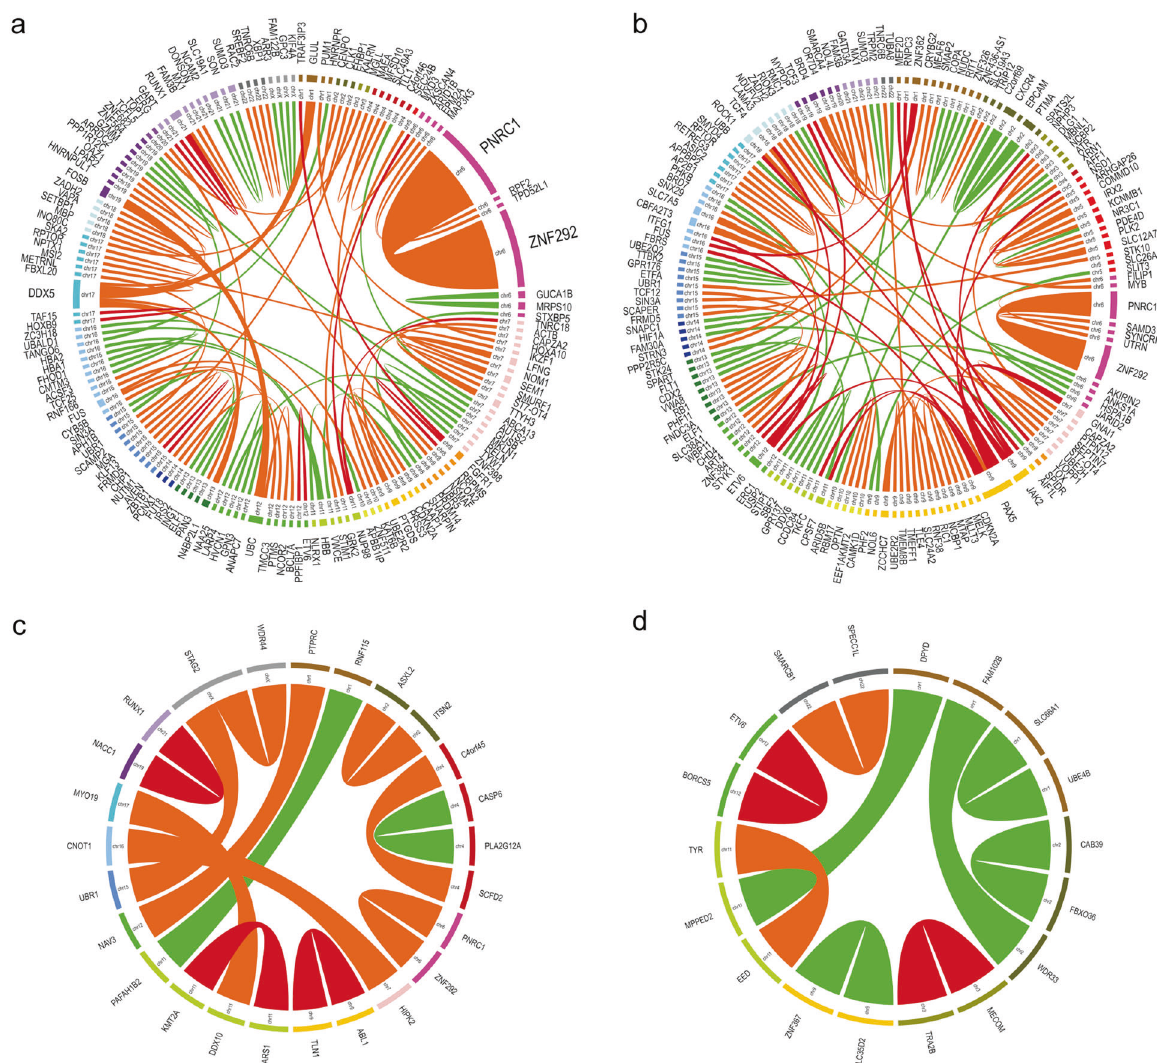
Fig. 6 Novel fusion genes detected in AML, B-ALL, T-ALL, and T-ALL. The plot was generated by Circos. The outside circle indicates the chromosomal location of the unique fusion genes. The arcs indicate novel fusions in AML ( a ), B-ALL ( b ), T-ALL ( c ), and MPAL ( d ). The width